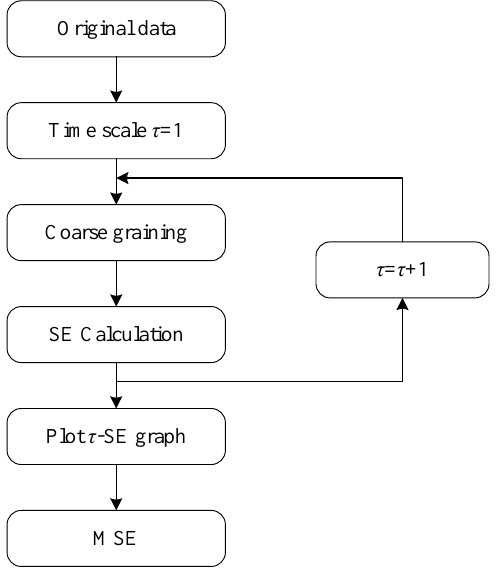
Figure 2. The illustration of MSE procedures.